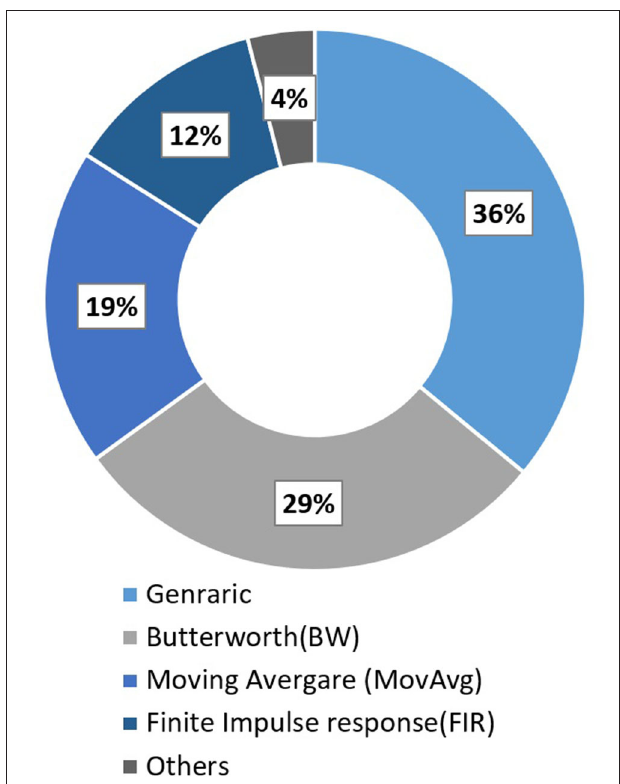
FIGURE 6 | Filter used in fNIRS studies in 2016 (Pinti et al.,